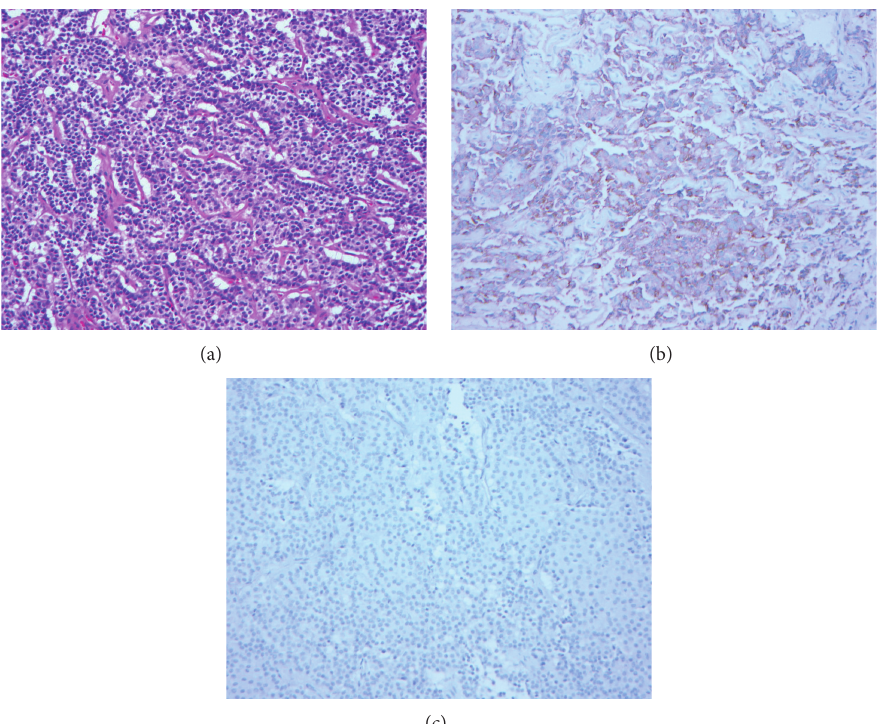
Figure 2: (a) H&E staining (magnification × 200) is characterized by many chromophobic epithelioid cells arranged in “pseudorosette” patterns. (b) Positive immunostaining of the tumor for FSH antibody and M3504 polyclonal antibody (DAKO, Carpinteria, CA) in 1: 200 dilution. (c) Negative immunostaining for LH antibody (in (c)), M3502, and C93 clone (DAKO) in 1:320